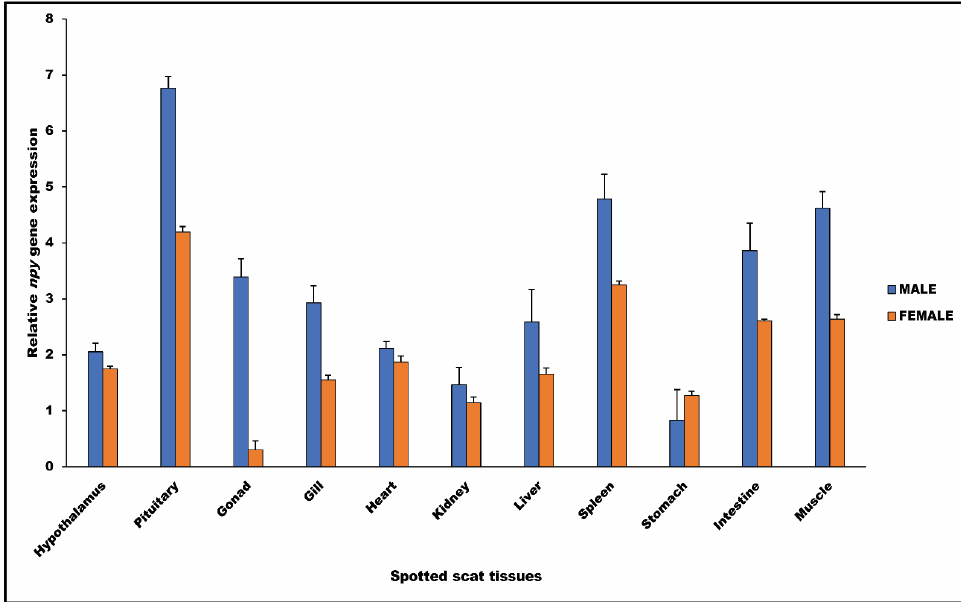
Figure 3. Tissue expression arrays of npy mRNA in the spotted scat. Amplification of β -actin was used as the in-house regulator. Data are given as mean ± standard error of the mean. used as the in-house regulator. Data are given as mean ± standard error of the